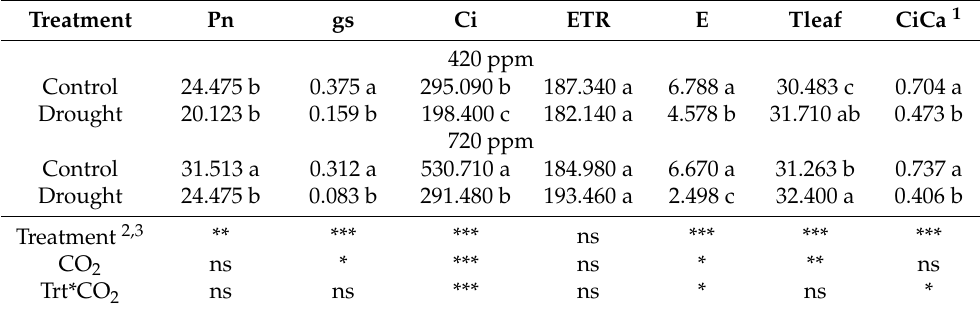
Table 2. The mean of net photosynthesis (Pn), stomatal conductance to water vapor (gs), intercellular CO 2 concentration (Ci), electron transport rate (ETR), leaf transpiration rate (E), leaf temperature (Tleaf), and intercellular/ambient CO 2 ratio (CiCa) of basil plants grown under without drought stress (control) and with drought stress at two levels of CO 2 (420 and 720 ppm) after 17 days of